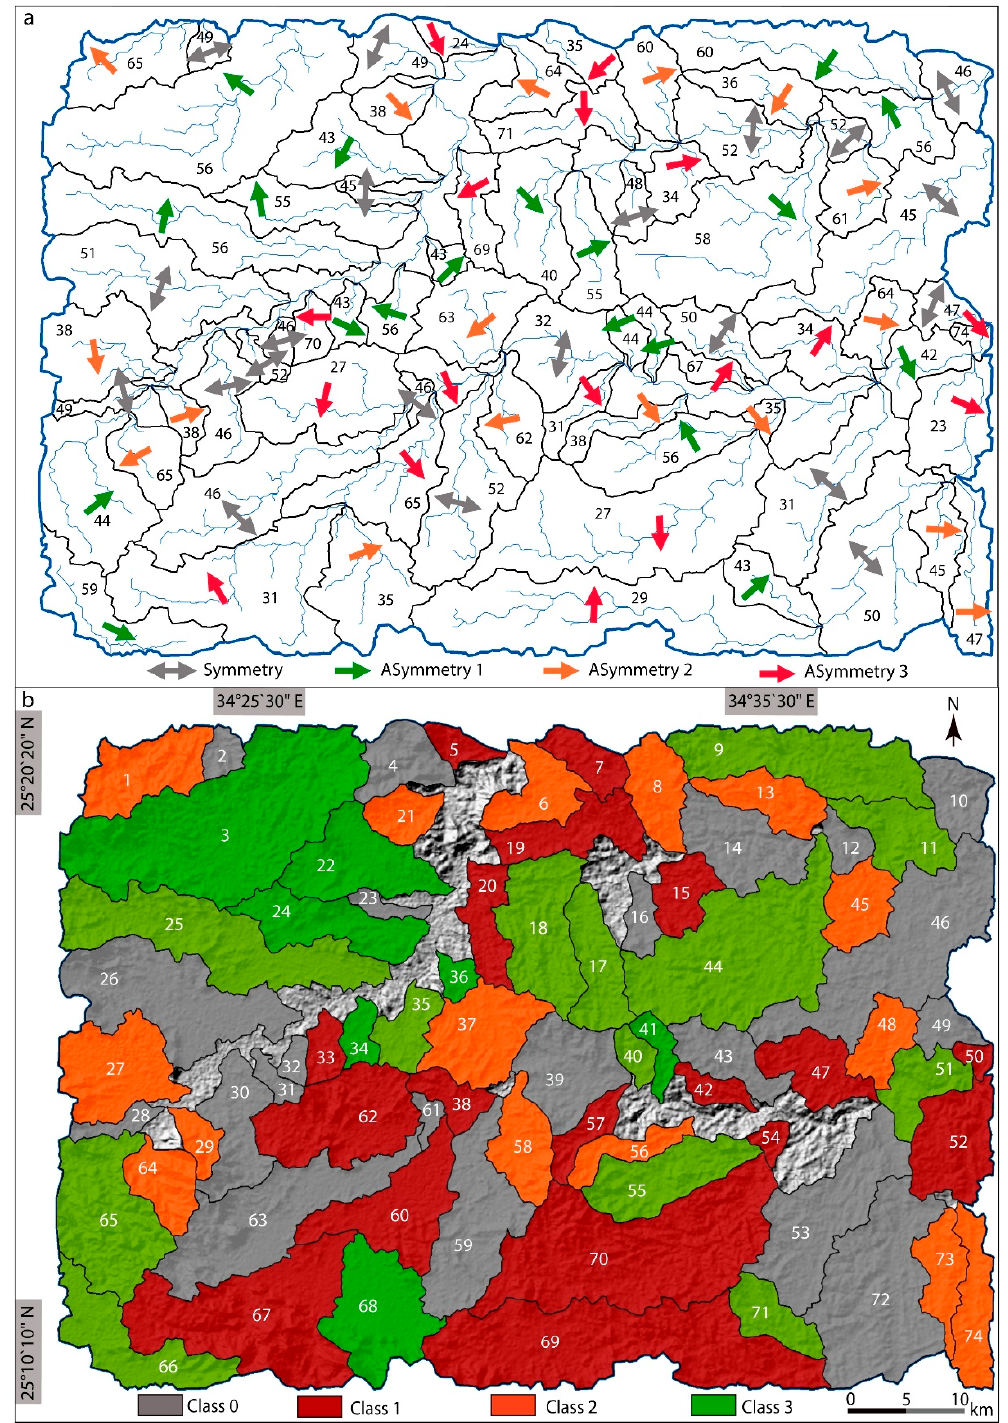
Figure 7. ( a ) Map illustrating tilting directions of sub-catchments. Black numbers refer to the A f values. ( b ) Map showing classes of A f index values. White numbers refer to the sub-catchment reference numbers.